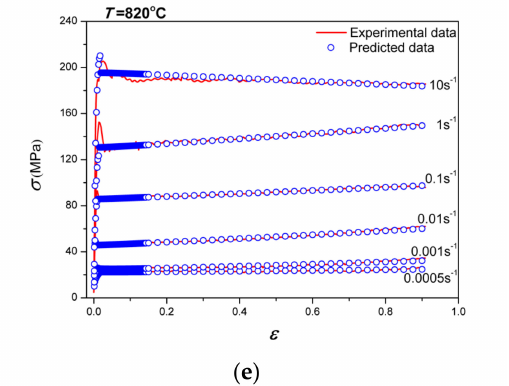
Figure 10. Comparisons between the experimental and the predicted flow stress by the MC model under the deformation temperatures of: ( a ) 740 ◦ C; ( b ) 760 ◦ C; ( c ) 780 ◦ C; ( d ) 800 ◦ C; and ( e ) 820 ◦